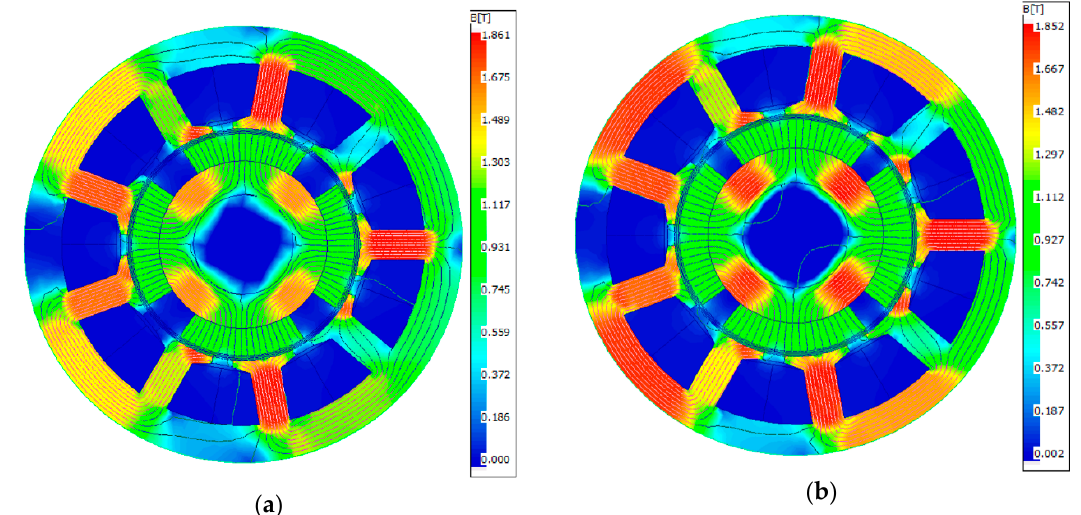
Figure 6. ( a ) Cloud diagram of motor magnetic flux density before optimization; ( b ) Cloud diagram of motor magnetic flux density after optimization.